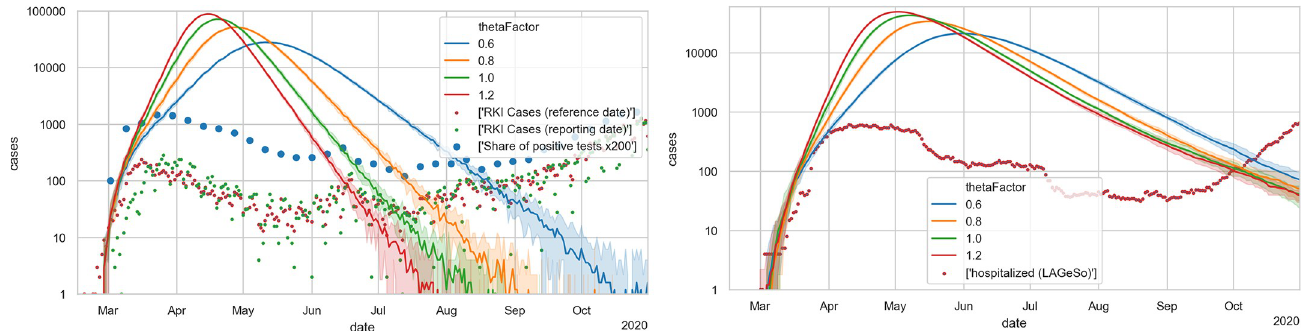
Fig 6. Unrestricted base case, but with initial disease import from data. LEFT: new cases; RIGHT: hospital occupancies. One finds that the initial slope dynamics is rather independent from the thetaFactor.